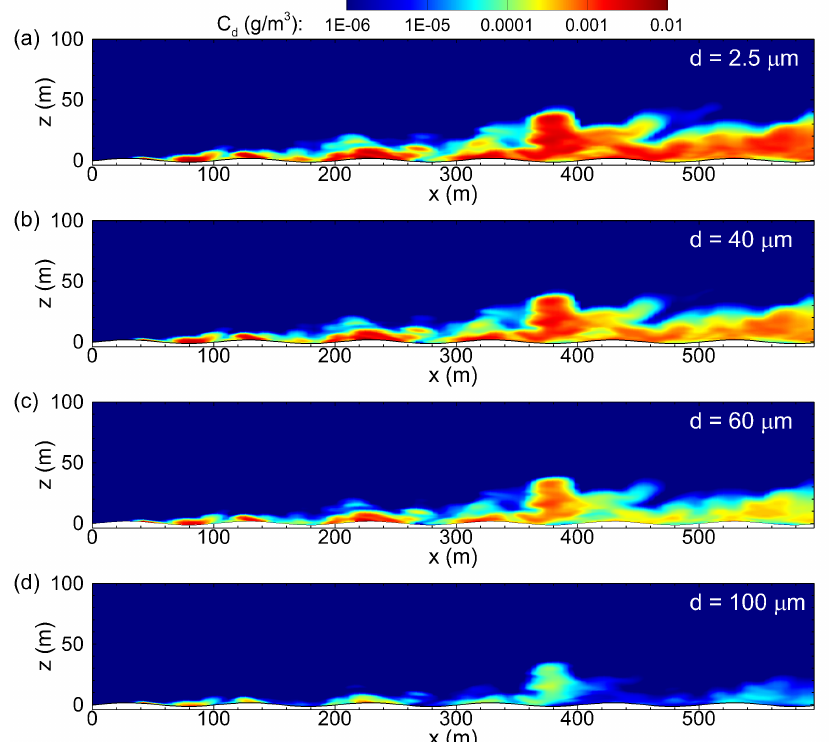
Figure 6. Instantaneous oil aerosol concentrations on the ( x , z ) -plane across the center of the surface release region for the swell wave case: ( a ) d = 2.5 µ m; ( b ) d = 40 µ m; ( c ) d = 60 µ m; ( d ) d = 100 µ